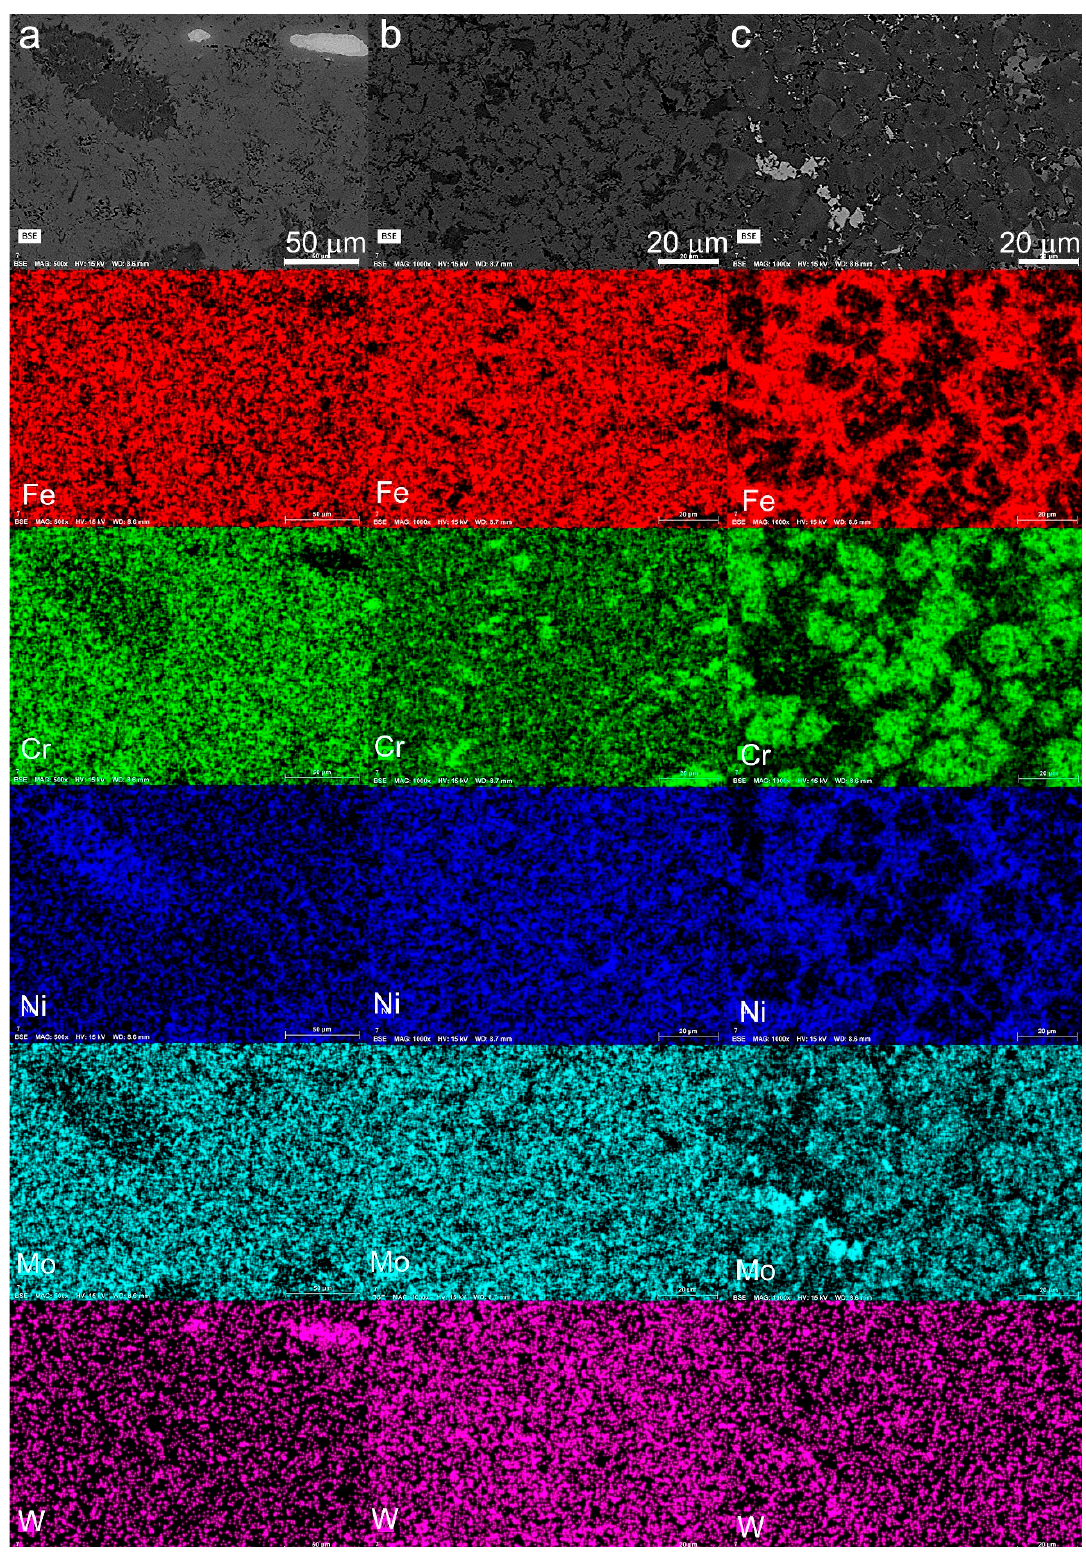
Figure 8. SEM image and EDX maps of Fe, Cr, Ni, Mo, and W for specimens produced by pressure- assisted sintering 35Fe30Cr20Ni10Mo5W: ( a )—from 5 h of mixing; ( b )—from milling for 2.5 h; ( c )— from milling for 5 h.